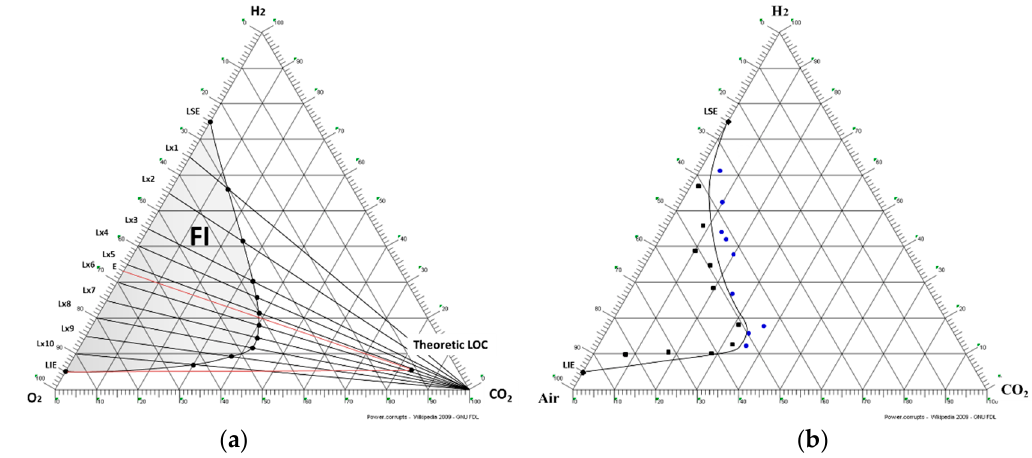
Figure 1. ( a ) Theoretic Flammability Interval (FI), and ( b ) Experimental Flammability